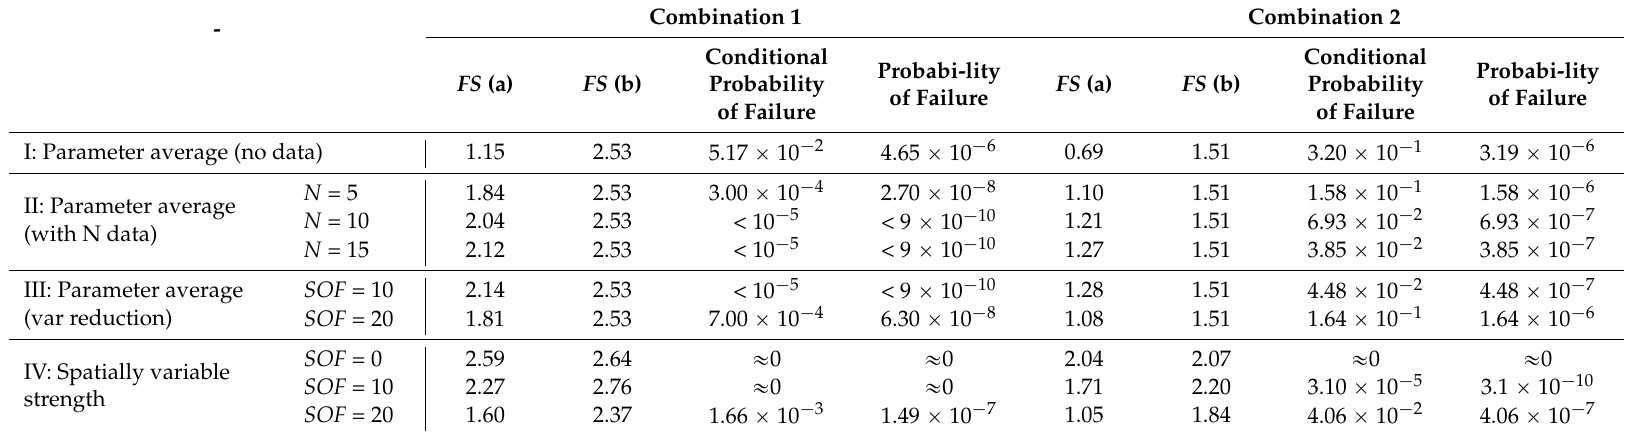
Table 20. Factors of safety and probabilities of failure with different